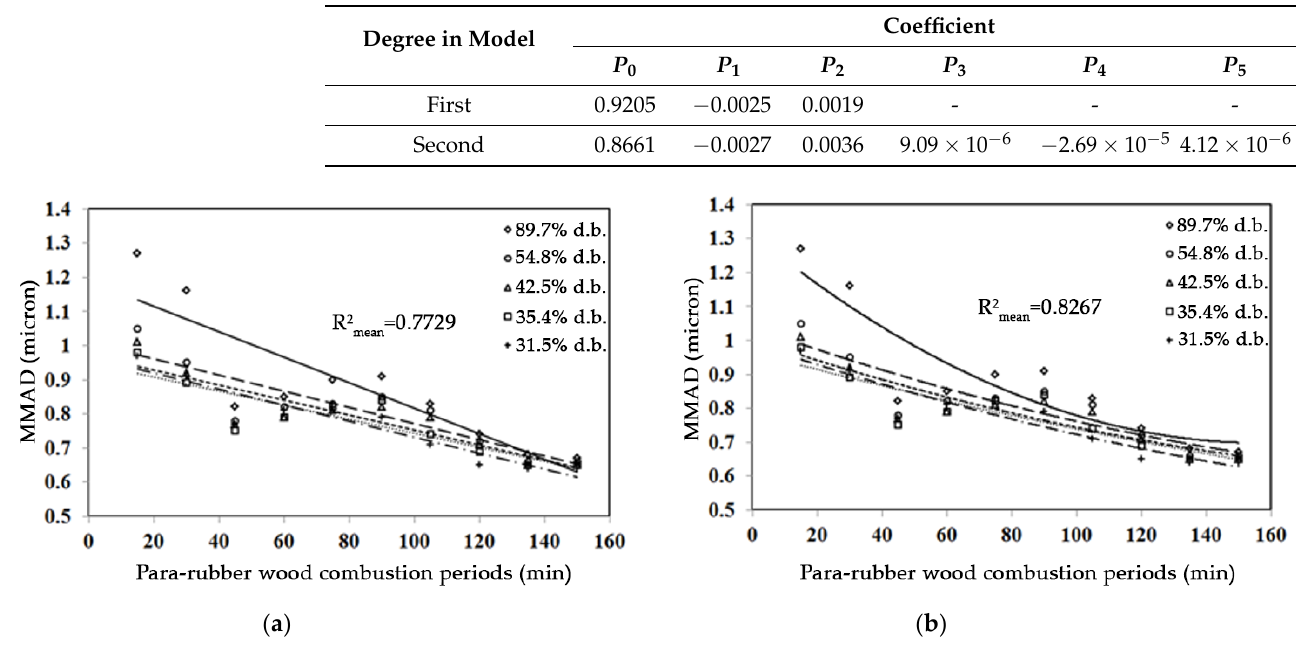
Figure 7. Comparison of predicted and experimental MMAD values: ( a ) First-degree model; ( b ) Second-degree model.